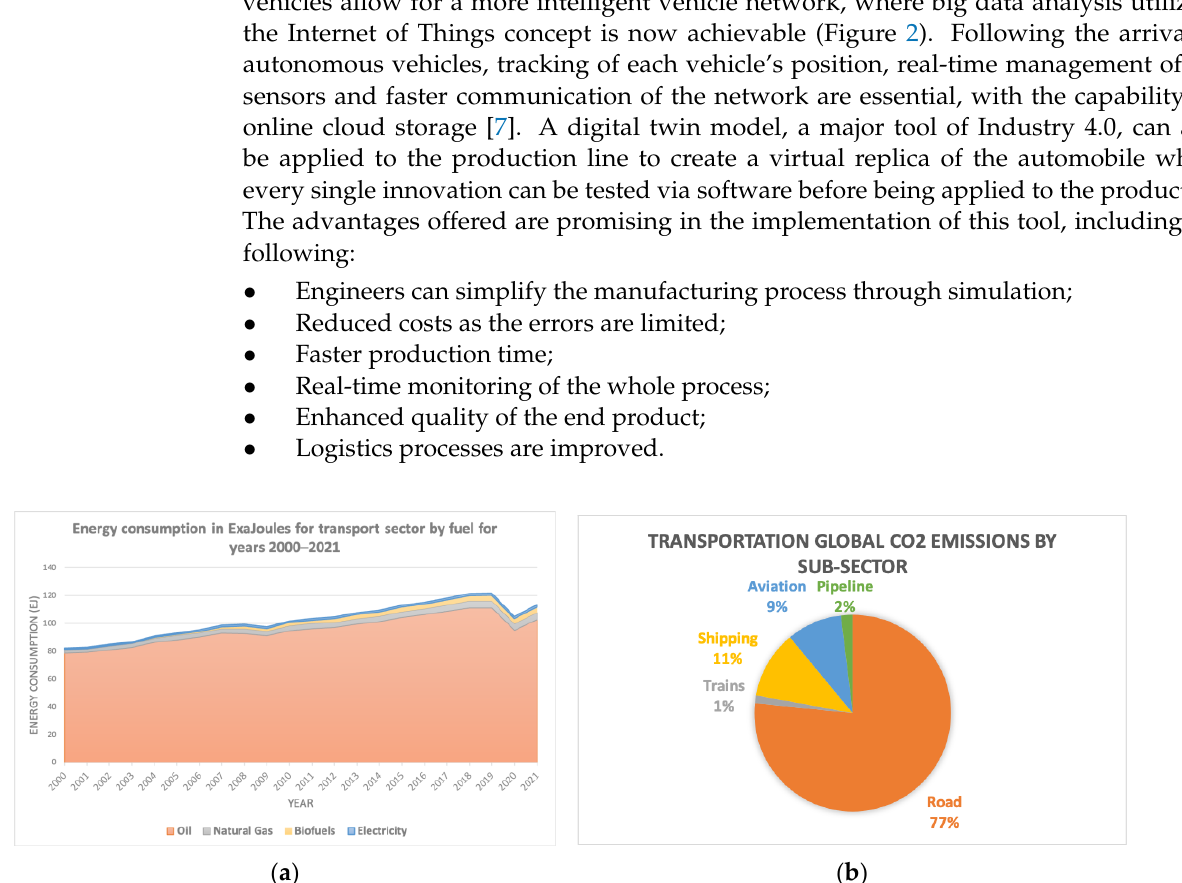
Figure 1. Global energy and CO 2 emissions for the transportation sector ( a ) Energy consumption consumed in the transportation sector in a 21-year scope [1]; ( b ) CO 2 emissions by subsector revealing the influence of road transport on greenhouse gases.